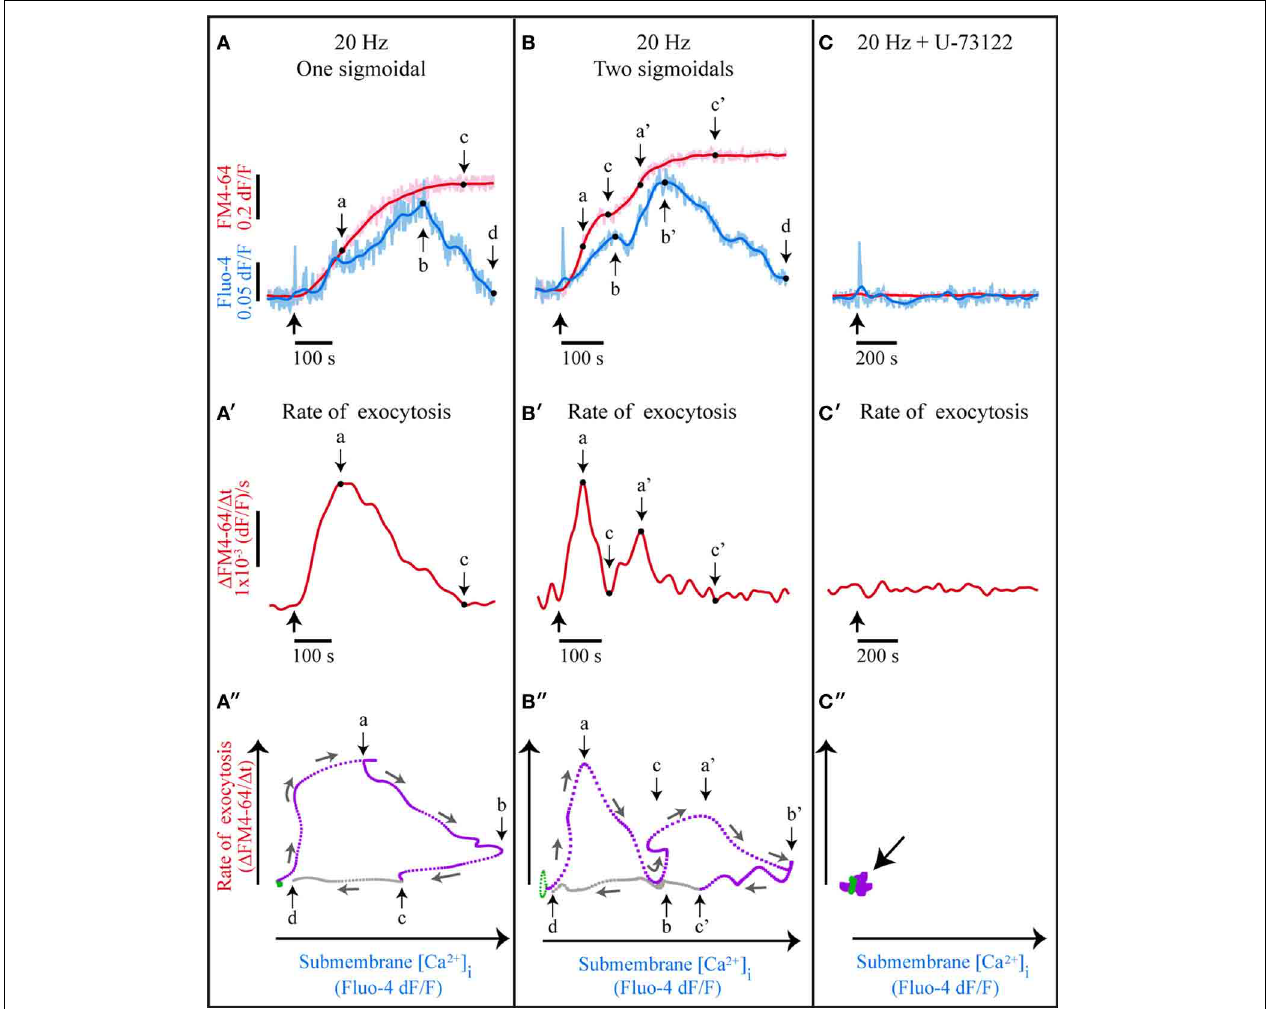
FIGURE 6 | A bistable system with a positive feedback loop sustains somatic exocytosis. (A) Kinetics of simultaneously acquired Fluo-4 (pale blue) and FM4-64 (pink) confocal fluorescence in response to 20-Hz stimulation. The smoothed kinetics are superimposed (dark blue and red traces, respectively). The thick black arrow indicates the stimulation onset; “a” indicates the maximal rate of exocytosis, as estimated from the differential of the kinetics shown in (A (cid:4) ) ; “b” is the peak of the large Ca 2 + transient; “c” is the end of exocytosis, when the differential value of the FM4-64 dye fluorescence is zero (see A (cid:4) ); “d” indicates the end of the large Ca 2 + transient. (B) Exocytosis and Ca 2 + kinetics displaying two sigmoidal increases upon subsequent exocytosis from two vesicle clusters. The large Ca 2 + transient also displays two peaks. “a (cid:4) –c (cid:4) ” are as in (A) , although applied to the second sigmoidal kinetics. (C) In the